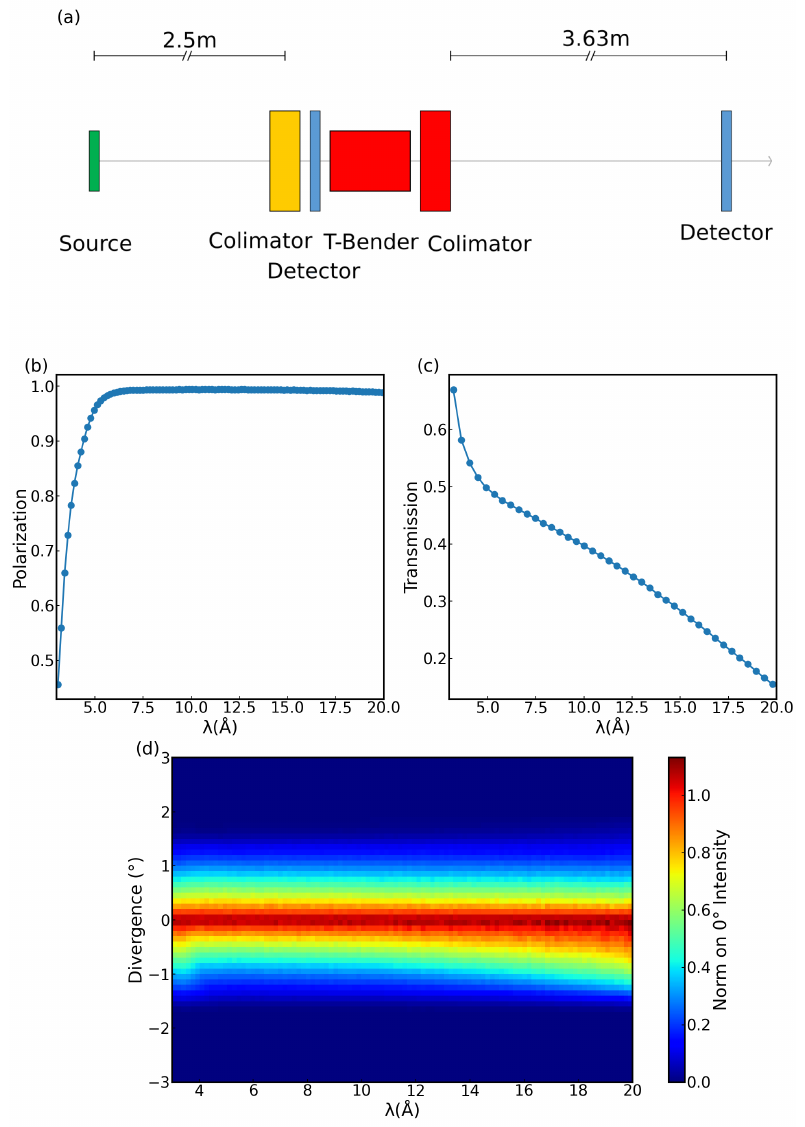
Figure 3. ( a ) Schematic depiction of the McStas setup used for the simulations. ( b ) Wavelength- dependent polarization of the transmission bender. ( c ) Wavelength-dependent transmission of the bender, with collimator. Around 10Å, the polarizer provides about 40 polarized neutrons, if 100 unpolarized neutrons enter the polarizer. ( d ) Wavelength dependent divergence of the beam, normalized to the intensity of the neutrons with a divergence of 0 ◦